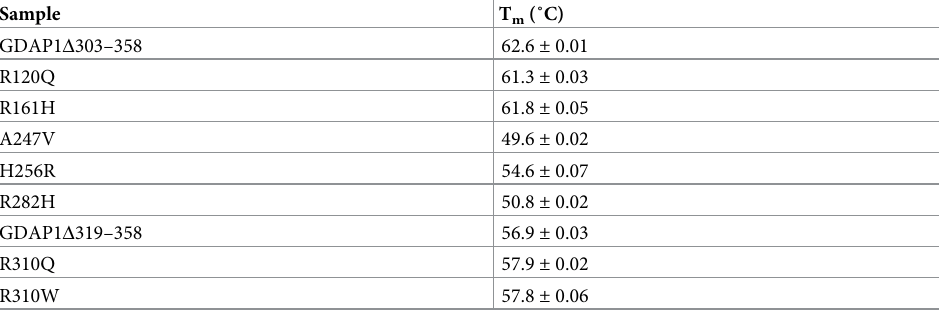
Table 3. nanoDSF apparent melting points. All values are average ± standard deviation from 3